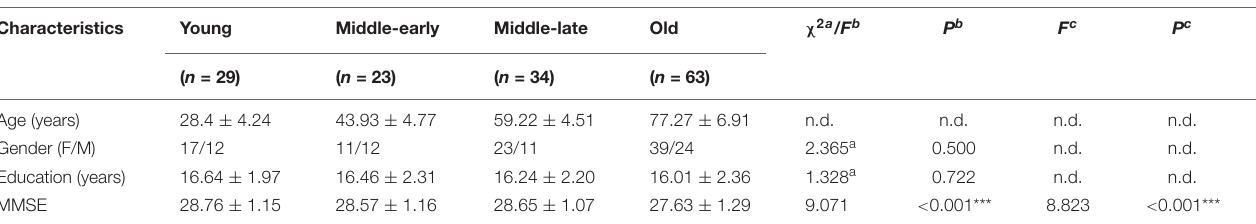
FIGURE 1 | Amygdala nuclei segmentation: (A) Amygdala nuclei segmentation in coronal view; (B) enlarged view of the right amygdala segmentation. La, lateral nucleus; Ba, basal nucleus; AB, accessory basal nucleus; Ce, central nucleus; Me, medial nucleus; Co, cortical nucleus; AAA, anterior amygdaloid area; CAT, cortico-amygdaloid transition area; PL, paralaminar nucleus; Whole, whole amygdala. TABLE 1 | Demographic information.